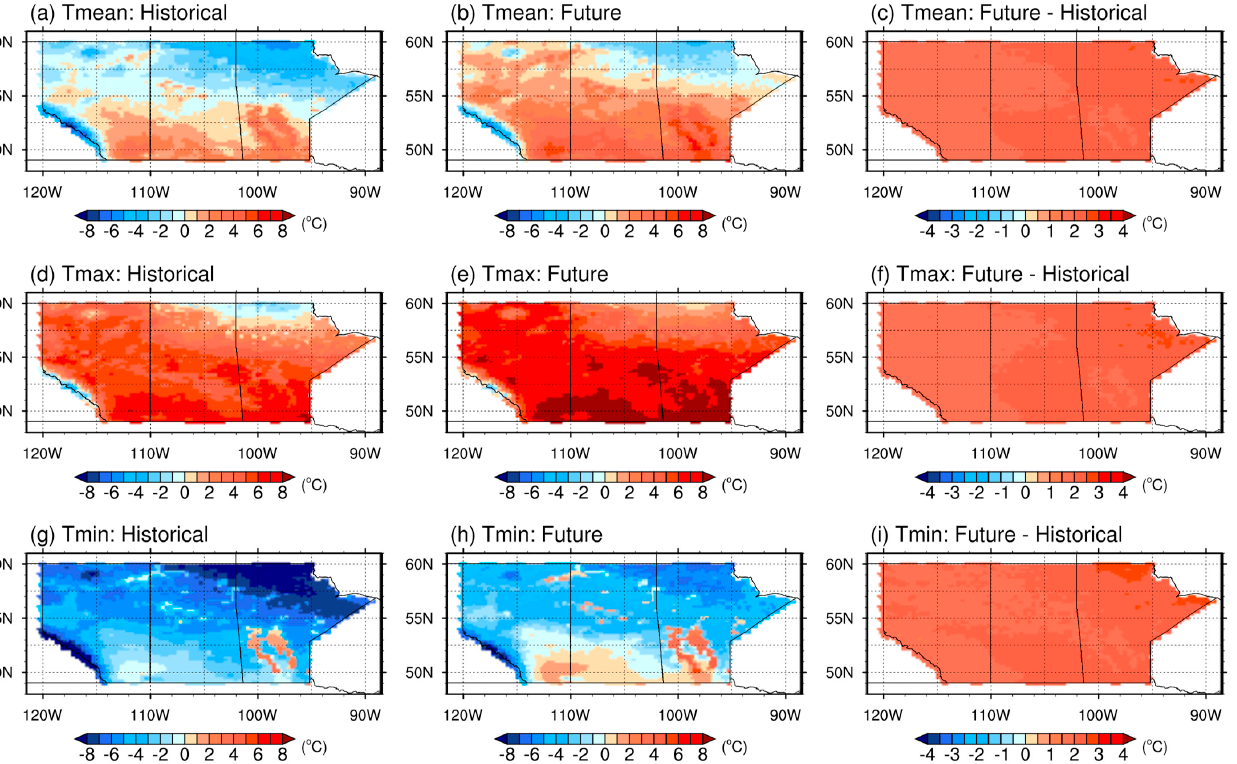
Figure 6. Projected variations of annual averages of T mean , T max , and T min for the period of 2036 to 2065 under RCP85. ( a , d , g ) show the historical distributions of T mean , T max , and T min , respectively; ( b , e , h ) show the future distributions of T mean , T max , and T min , respectively; ( c , f , i ) show the projected variations of V mean , V max , and V min , respectively.